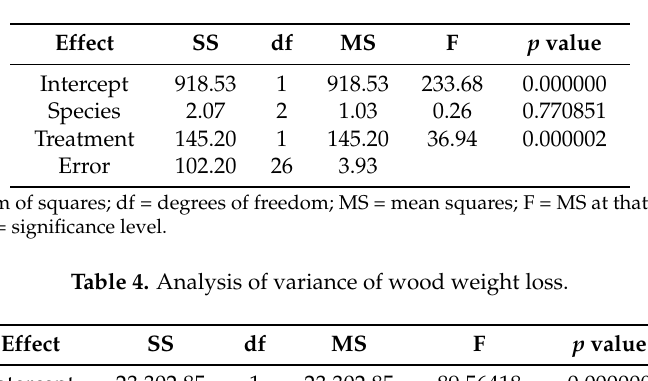
Table 3. Analysis of variance of the rating of wood resistance against termite attack.